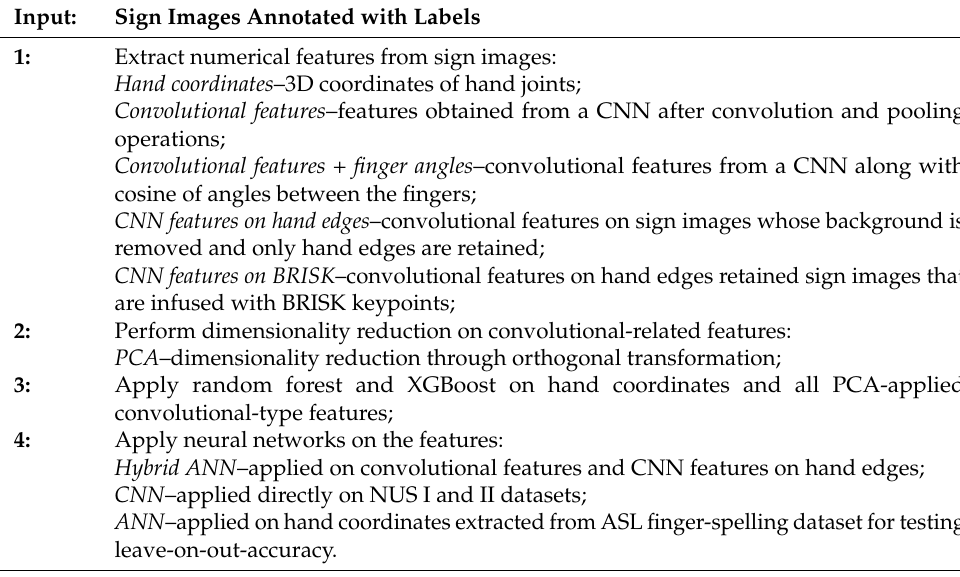
Table 3. Methodology for sign image classification.